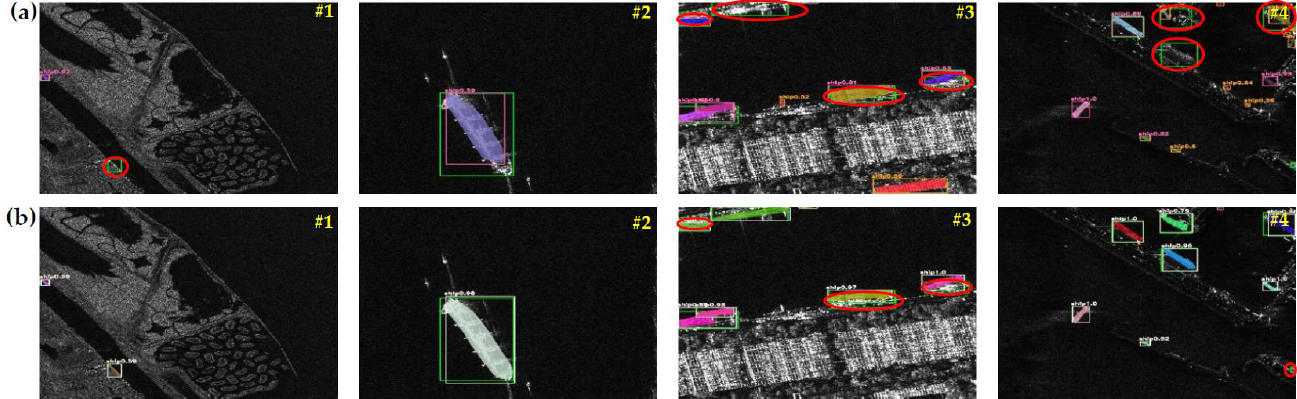
Figure 17. Qualitative results on HRSID. ( a ) GROIE with the second-best mask AP. ( b ) GCBANet. Green boxes denote the ground truths. Orange boxes denote the false alarms (i.e., false positives, FP). Red circles denote the missed detections (i.e., false negatives, FN). #i denote the ith picture of results.